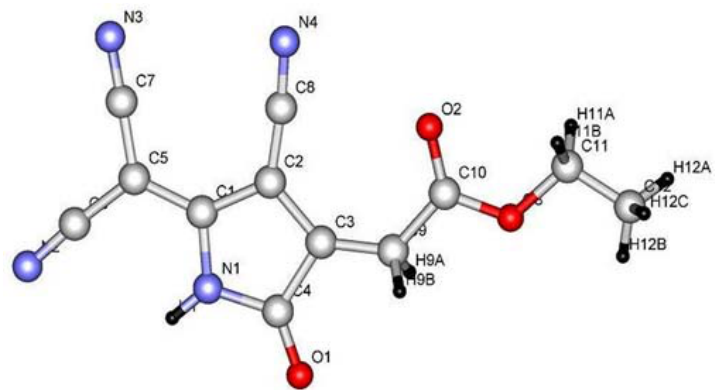
Figure 3. X-ray crystal structure of compound 15A